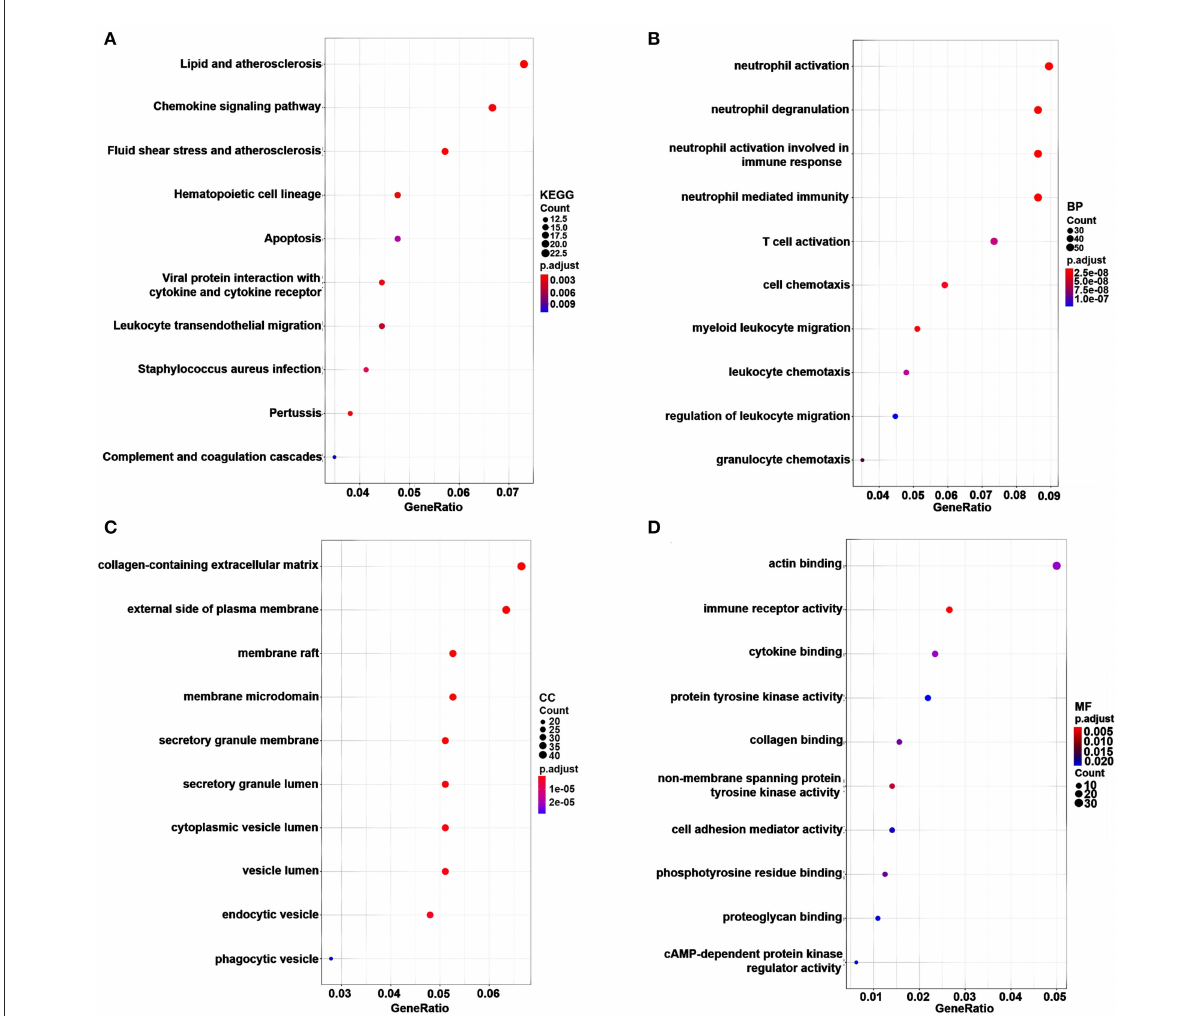
FIGURE3 KEGG pathway and GO functional enrichment analyses for genes in the pink, brown and cyan modules. The gene number is represented on the x-axis, and the KEGG pathway and GO terms are presented on the y-axis. (A) KEGG pathway. (B) Biological process. (C) Cytological components. (D) Molecular